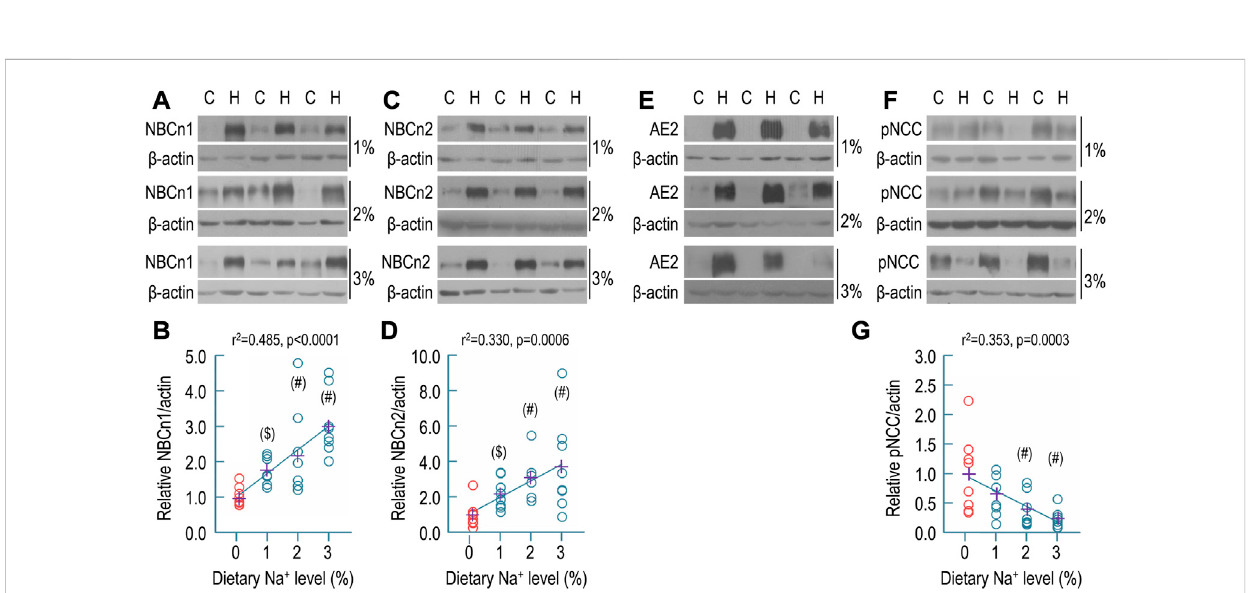
FIGURE 5 Effect of dietary sodium on the expression of NBCn1, NBCn2, AE2, and pNCC in rat kidney. (A) Representative western blots for the expression of NBCn1inthekidney. (B) SummaryfortherelativeabundanceofrenalNBCn1. (C) Representative westernblotsfortheexpressionofNBCn2inthekidney. (D) Summary for the relative abundance of renal NBCn2. (E) Representative western blots for the expression of AE2 in the kidney. The abundance of AE2 was strikingly increased by dietary sodium. It was not practical to determine therelativeratio of AE2 abundanceof high sodium groups over the control. (F) Representative western blots for the expression of pNCC in the kidney. (G) Summary for the relative abundance of renal pNCC. Western blotting analyses were performed with the membrane preparations of whole kidney. C: control normal (0.1% Na + ). H: high sodium diet. Each data point (circles) represents an individual rat ( n = 8 for each condition). The data points of the control (0.1% of Na + ) are presented in red. The crosses in purple indicate the means of protein levels in each condition. #: signi fi cantly different from the control (red) by one-way ANOVA followed by Dunnet ’ s multiple comparison ( p < 0.05). $: signi fi cantly different from the control by Student ’ s t-test ( p <